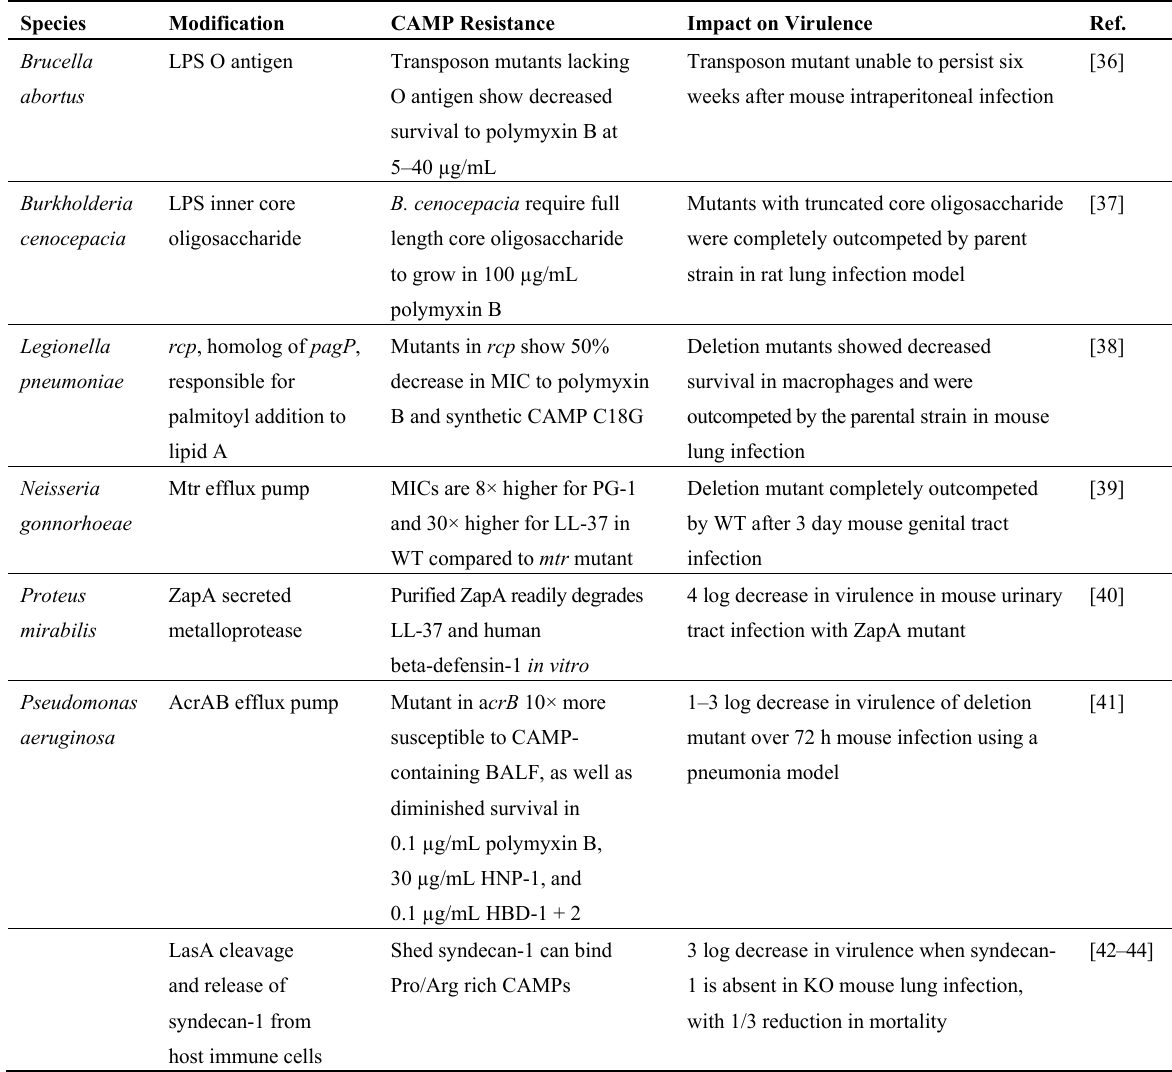
Table 1. Links between CAMP resistance and virulence of Gram-negative